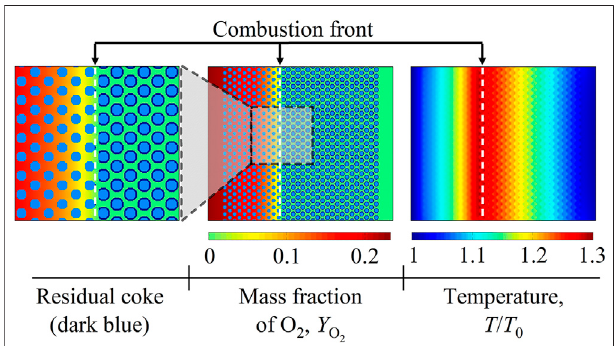
FIGURE 9 | Contours of residual coke, the O 2 mass fraction Y O temperature T / T 0 for the base case with R y (cid:2) 0 and R t (cid:2) 0 at t (cid:2) 5.62 s.